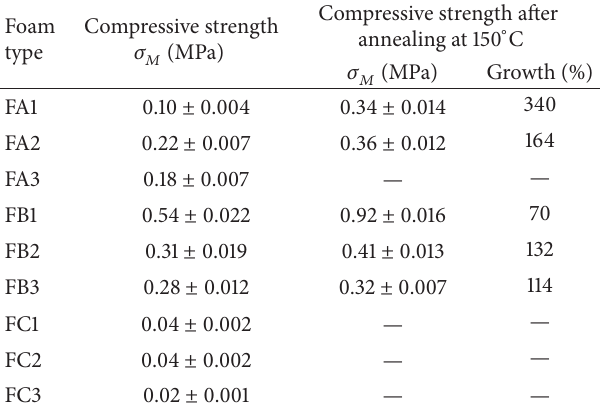
Table 8: Compressive strength of the obtained polyurethane